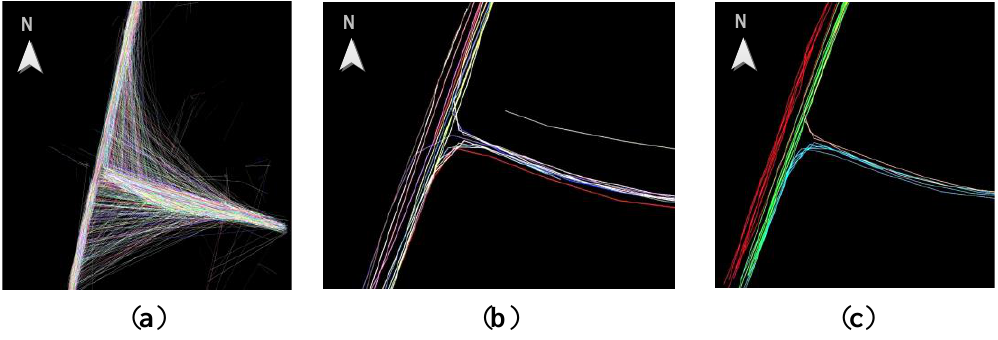
Figure 9. Trajectory tracking. ( a ) indicates the trajectories with 40 s sampling interval; ( b ) shows the trajectories with 20 s sampling interval; ( c ) descripts the different driving directions of vehicles.